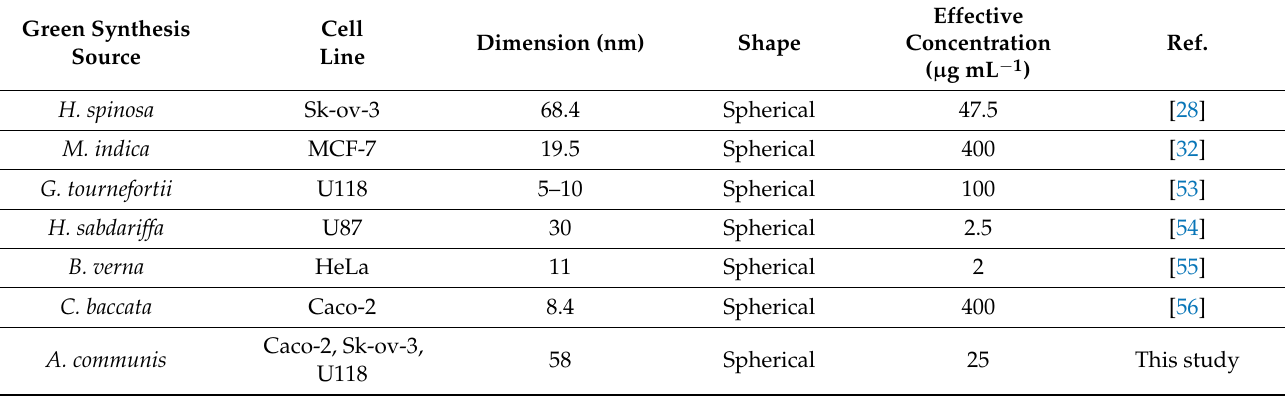
Table 6. Comparison of the % viability-suppressing effect concentrations of some green-synthesized AuNPs on different cancer cell lines.